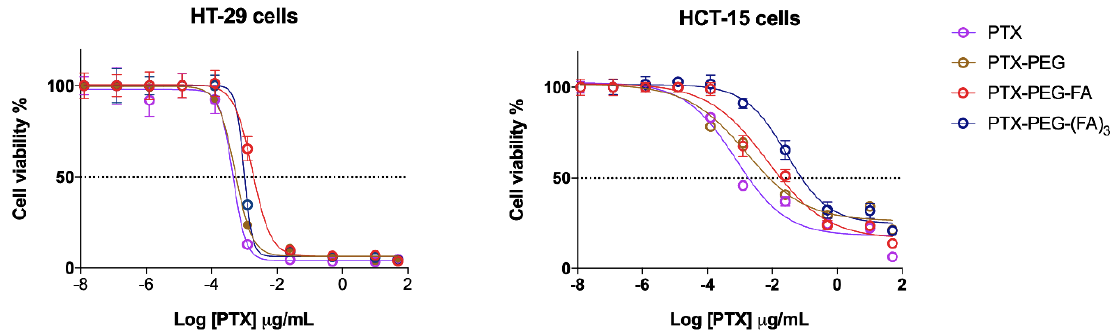
Figure 3. Cytotoxicity of PTX and PTX conjugates in FR-positive (HT-29) and FR-negative (HCT-15) cells. The results are the mean of three independent experiments, each performed in triplicate.